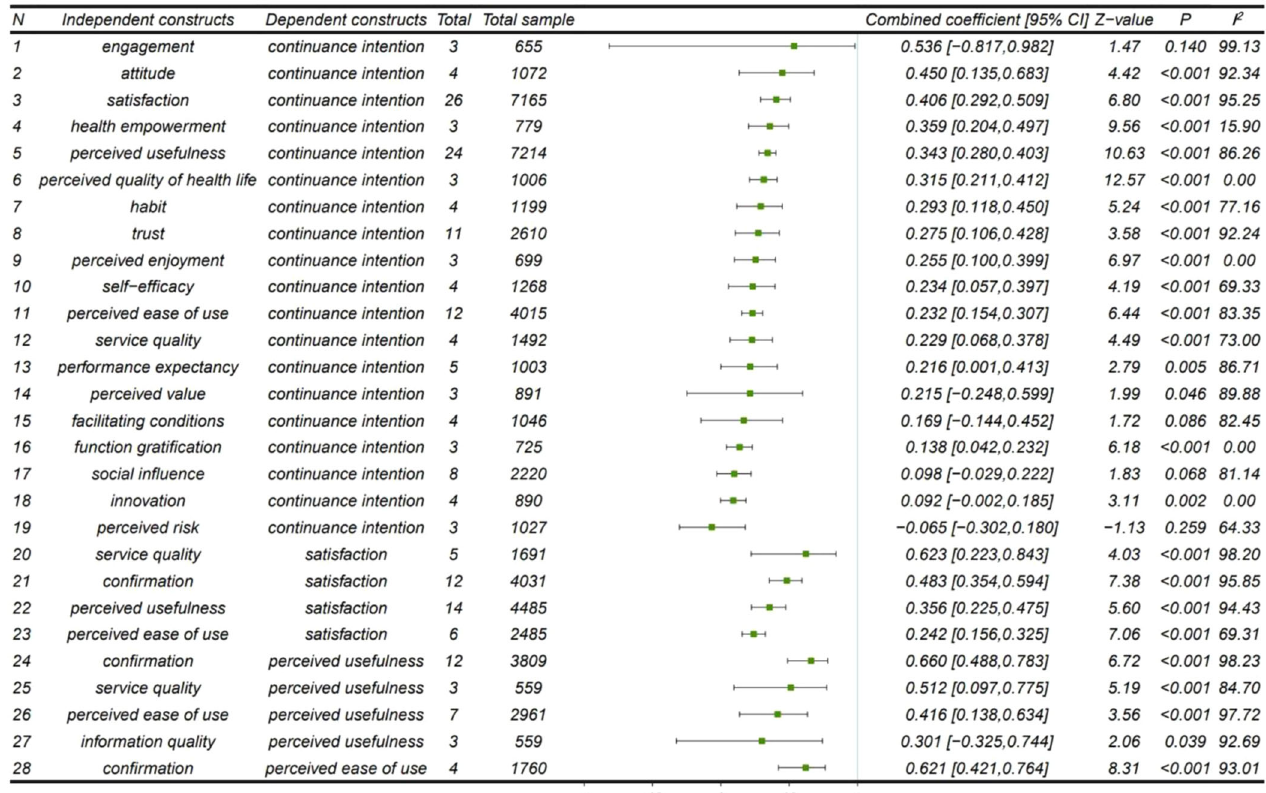
Fig. 2 Summary estimation of pooled effect of coef fi cients using forest plot. Data presented forest plot of in fl uence relationships included in the meta-analysis (28 in fl uence relationships). P : p -value for the combined coef fi cient signi fi cance test of the effect of the independent constructs on the dependent